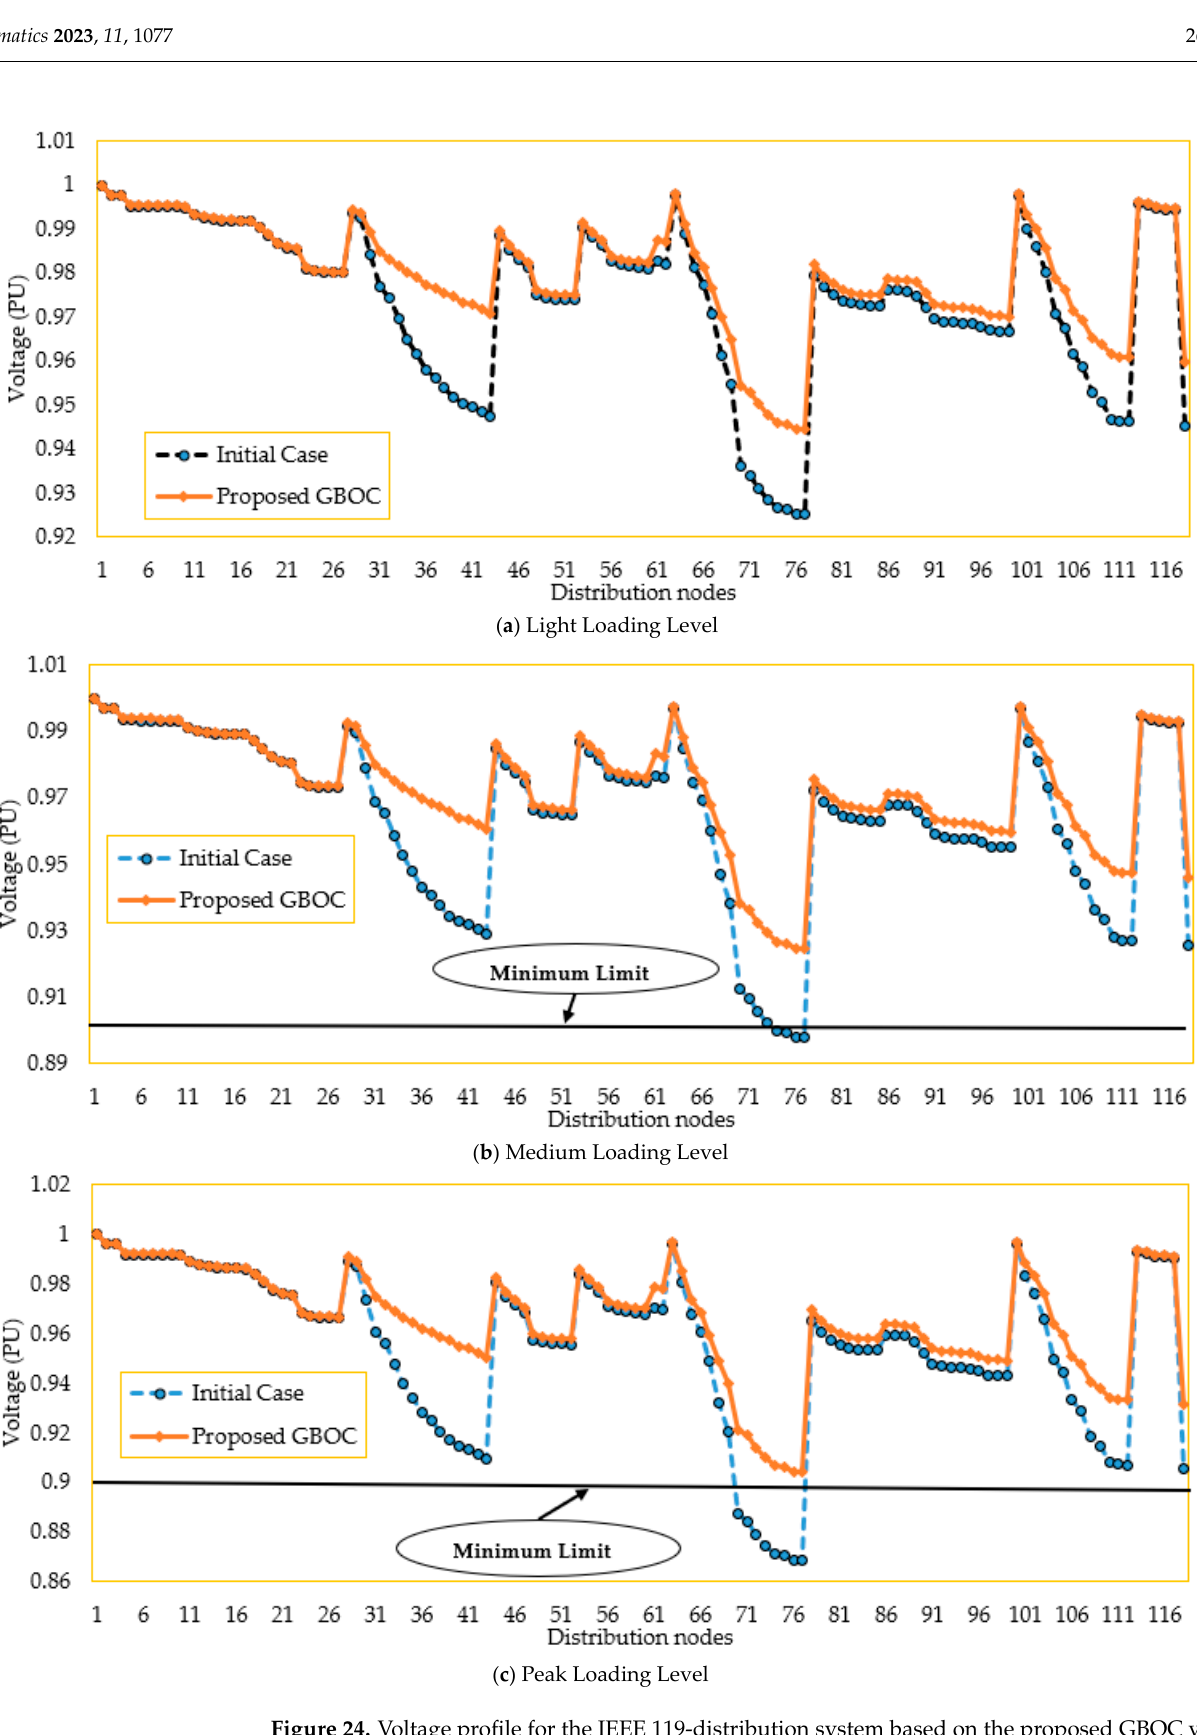
Figure 24. Voltage profile for the IEEE 119-distribution system based on the proposed GBOC versus initial case.